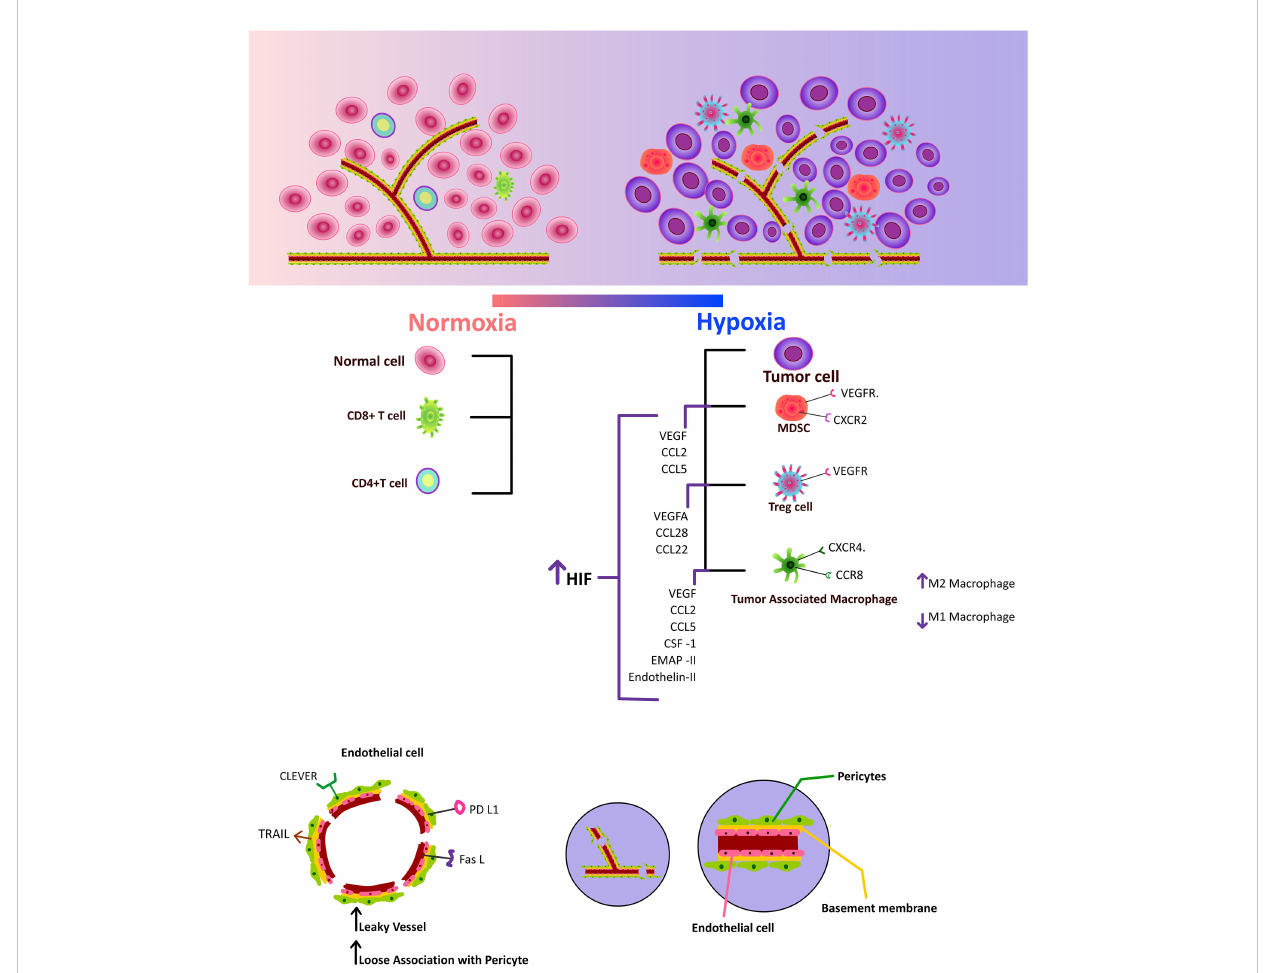
FIGURE 2 Increased hypoxia inducible factor, which upregulates pro-angiogenic factors and chemokines, draws immunosuppressive cells to the tumor microenvironment. Additionally, increased CLEVER, TRAIL, PD-L1, and FAS-L expression on tumor endothelium impairs effector T